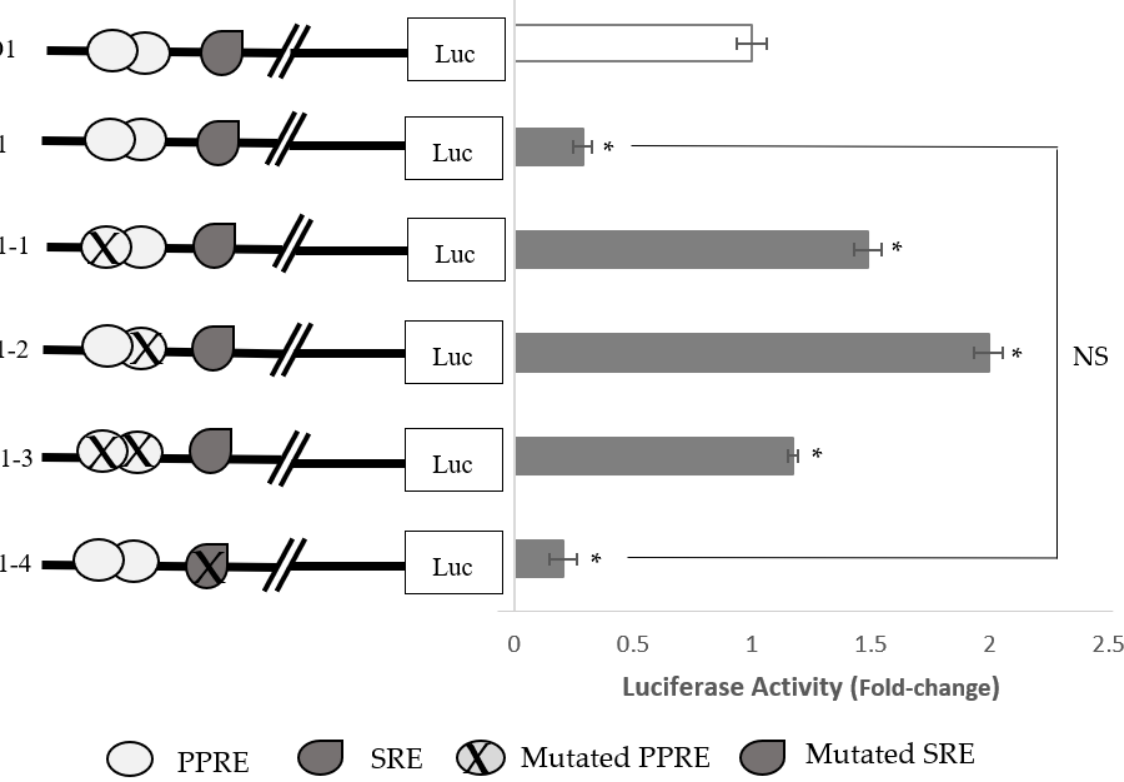
Figure 7. The effects of mutated PPRE and SRE on PCSK9 promoter activity. The activity of the wild-type promoter construct without treatment with the selected A. planci fraction was assigned as the control level (open bar), and the transcriptional activity of promoter constructs in the cells treated with the selected fraction (closed bar) are represented relative to the control value. The data shown are representative of 3 independent experiments, and each experiment was carried out in triplicate (PPRE, peroxisome proliferator response element; SRE, sterol regulatory element; Sp1, specificity protein 1; HNF-1, hepatocyte nuclear factor 1; HINFP, histone nuclear factor P). * Indicates statistical significance ( p < 0.05) compared with the untreated control. NS indicates no statistical significance ( p > 0.05) between the two compared samples.